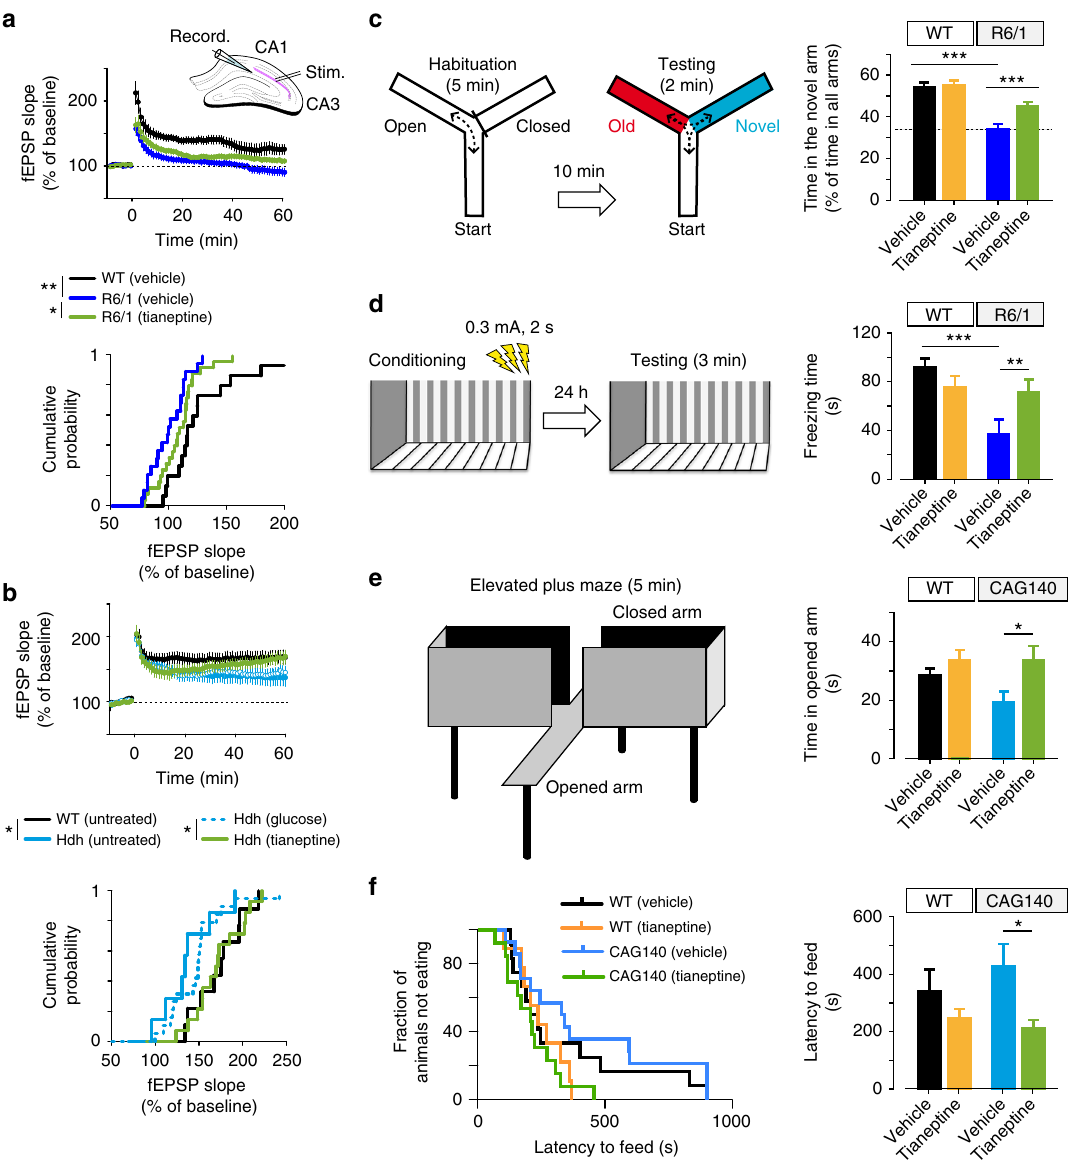
Fig. 7 Tianeptine restores hippocampal LTP and memory and ameliorates anxiety/depression like behavior in complementary HD mouse models. a , b Field EPSPs (fEPSPs) were recorded in CA1 region containing acute slices of differently treated R6/1 ( a ) and Hdh Q111/Q111 mice ( b ) following theta-burst stimulation of the Schaffer collaterals. The percentages of potentiation during last 10 min of each recordings were plotted in cumulative probability curves (bottom panels); n = 16, 22, and 26 slices for vehicle-treated WT and R6/1 mice and tianeptine-treated R6/1 mice; n = 10, 8, 20, 15 slices for untreated WT, Hdh Q111/Q111 mice, and glucose- and tianeptine-treated Hdh Q111/Q111 mice. c , d Hippocampus-dependent memory was examined using Y-maze ( c ) and contextual fear conditioning paradigm ( d ) in vehicle- or tianeptine-treated R6/1 and WT littermate mice. c Left, schematic diagram for Y-maze; right, percentage of time spent by mice in novel arms to that in total arms during 2-min testing time. d Left, schematic diagram for contextual fear conditioning; right, freezing time during 3-min testing time; n = 25, 28, 33, and 32 mice ( c ) and n = 10, 10, 10, and 12 mice ( d ) for vehicle- and tianeptine-treated WT and R6/1 mice. e , f Anxiety/depression-like behaviors were evaluated with elevated plus maze (EPM) ( e ) and novelty-suppressed feeding (NSF) paradigm ( f ) in HD CAG140 knock-in mice and WT littermates. e Left, schematic diagram for EPM; right, time spent in open arms in EPM, which is an anxiety index. f Values plotted were cumulative survival of animals that did not eat over 15 min (left) or mean of latency to feed in seconds (right). The latency to begin eating is an index of anxiety/depression-like behavior; n = 12, 9, 14, and 13 mice for vehicle- and tianeptine-treated WT and CAG140 mice ( e , f ). Data values are mean ± s.e.m ( c – f ). Signi fi cance was assessed by Mann – Whitney/Wilcoxon ’ s test ( a , b ), and two-way ANOVA followed by Tukey multiple comparison test with genotype and treatment as the between-subjects factors ( c – f ); * P < 0.05, ** P < 0.01, *** P <